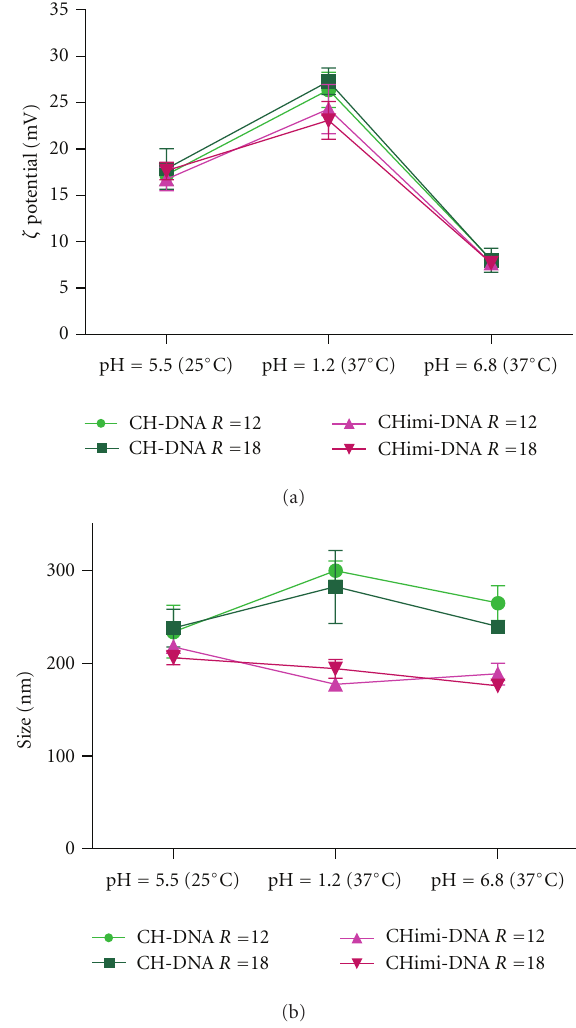
Figure 3: Zeta potential (a) and mean size (b) of CH-based complexes prepared in N/P molar ratios (R) 12 and 18 at di ff erent media. The measures were realized at 25 ◦ C in acetate bu ff er pH 5.5 and at a 37 ◦ C in SGF and